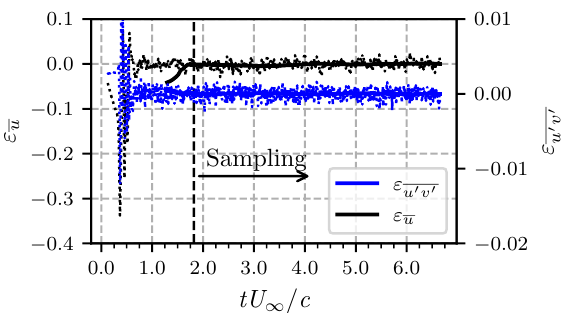
Figure 3. Temporal evolutions of the local mean streamwise velocity and the Reynolds shear stress near the TE over the non-dimensional time.